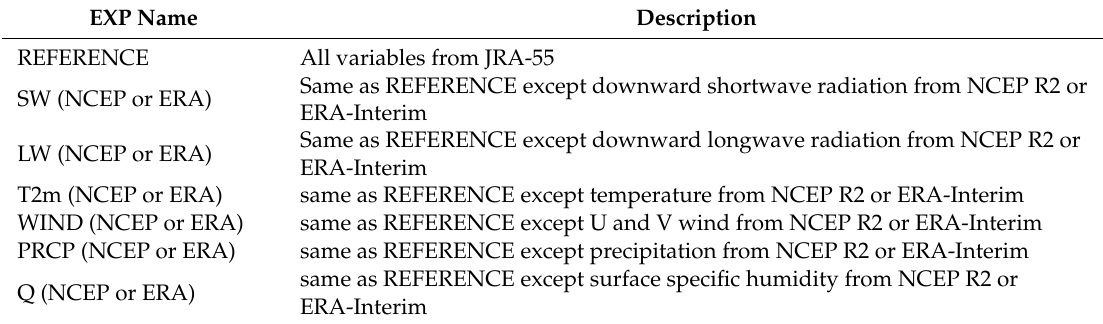
Table 2. Description of the CICE5 response experiments for various atmospheric